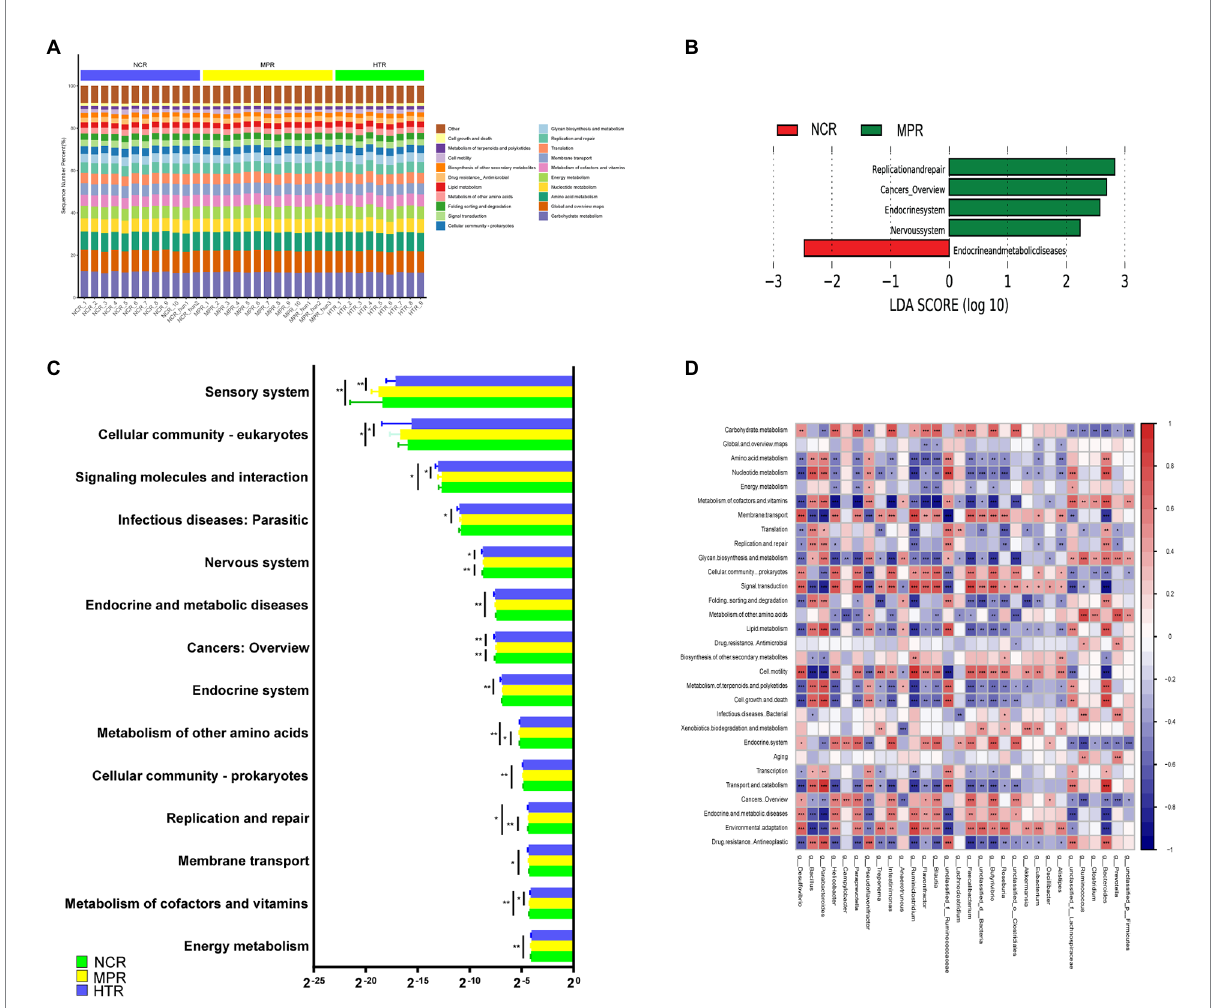
( sav1866 , ImrD and msbA was lowest in the HTR ( p < 0.05; Figure 4D; Supplementary Table S4). Notably, ARG density was the lowest in the NCR. According to the LefSe, the ARGs in the NCR were enriched in Saur_gyrA_FLO , hmrM , Ecol_folP_SLF , etc. ARGs in the MPR were enriched in bcrA , macB , cea , etc. ARGs in the HTR were enriched in Saur_rpoC_DAP , aminocoumarin-resistance alaS , and Saur_rpoB_RIF (Figure 4E). Nine unique plasmids were recovered from the 34 samples, with in the MPR than in the NCR and HTR (Figure